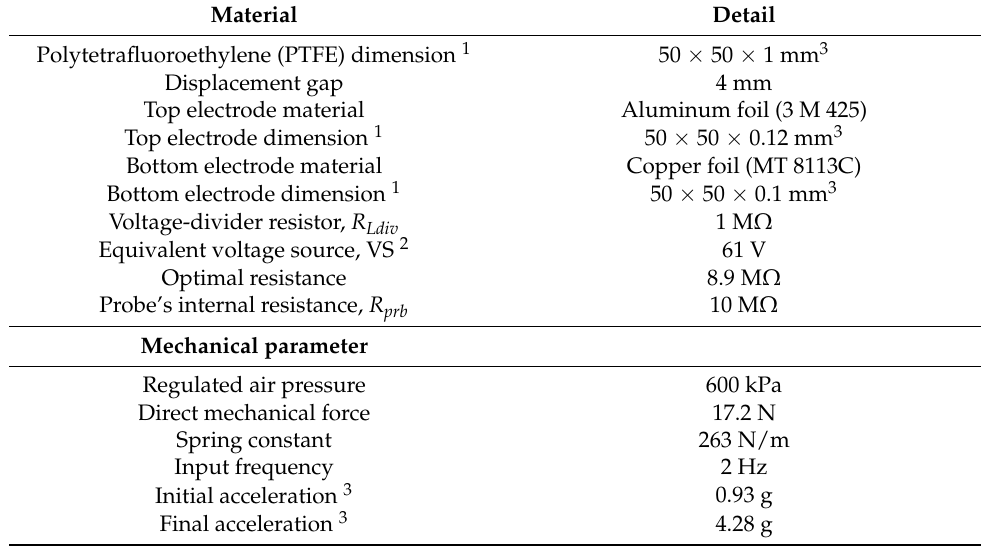
Table 2. Details of materials and mechanical parameters used in the